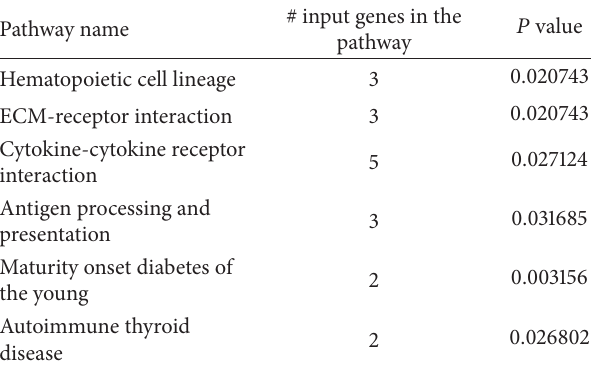
Table 2: Molecular pathways upregulated by